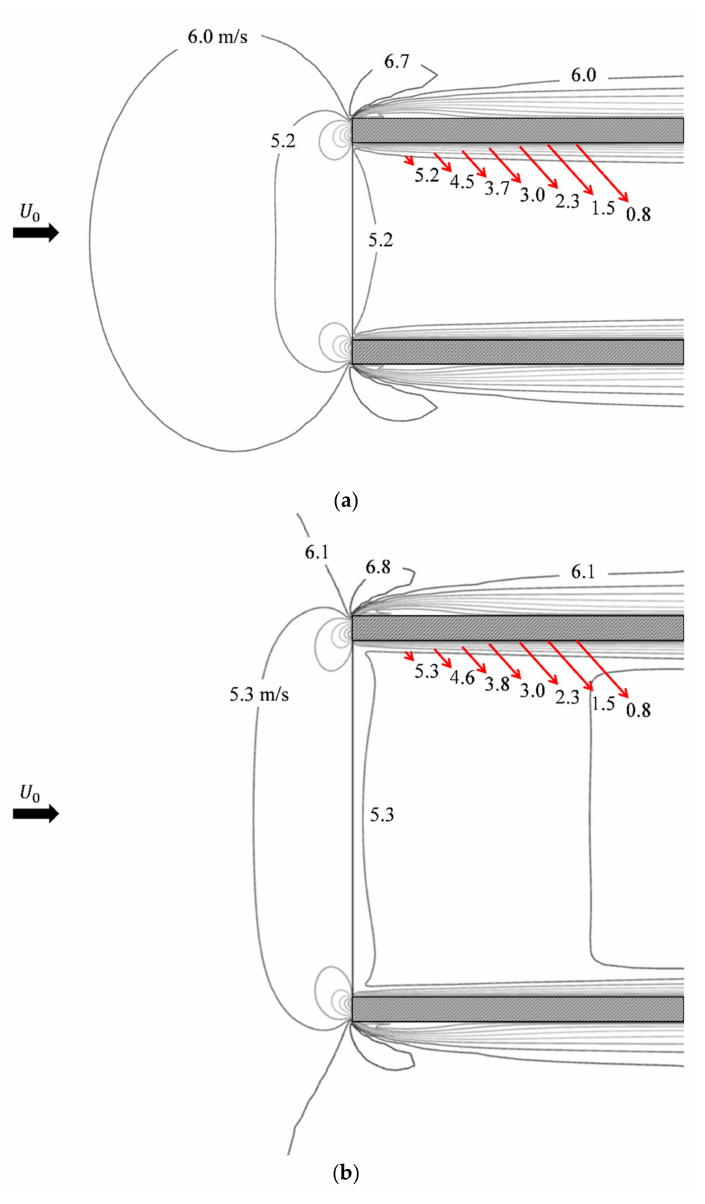
Figure 6. Velocity distribution of sampling probe at free-stream velocity of 5 m/s: ( a ) circular inlet; and ( b ) ellipsoidal